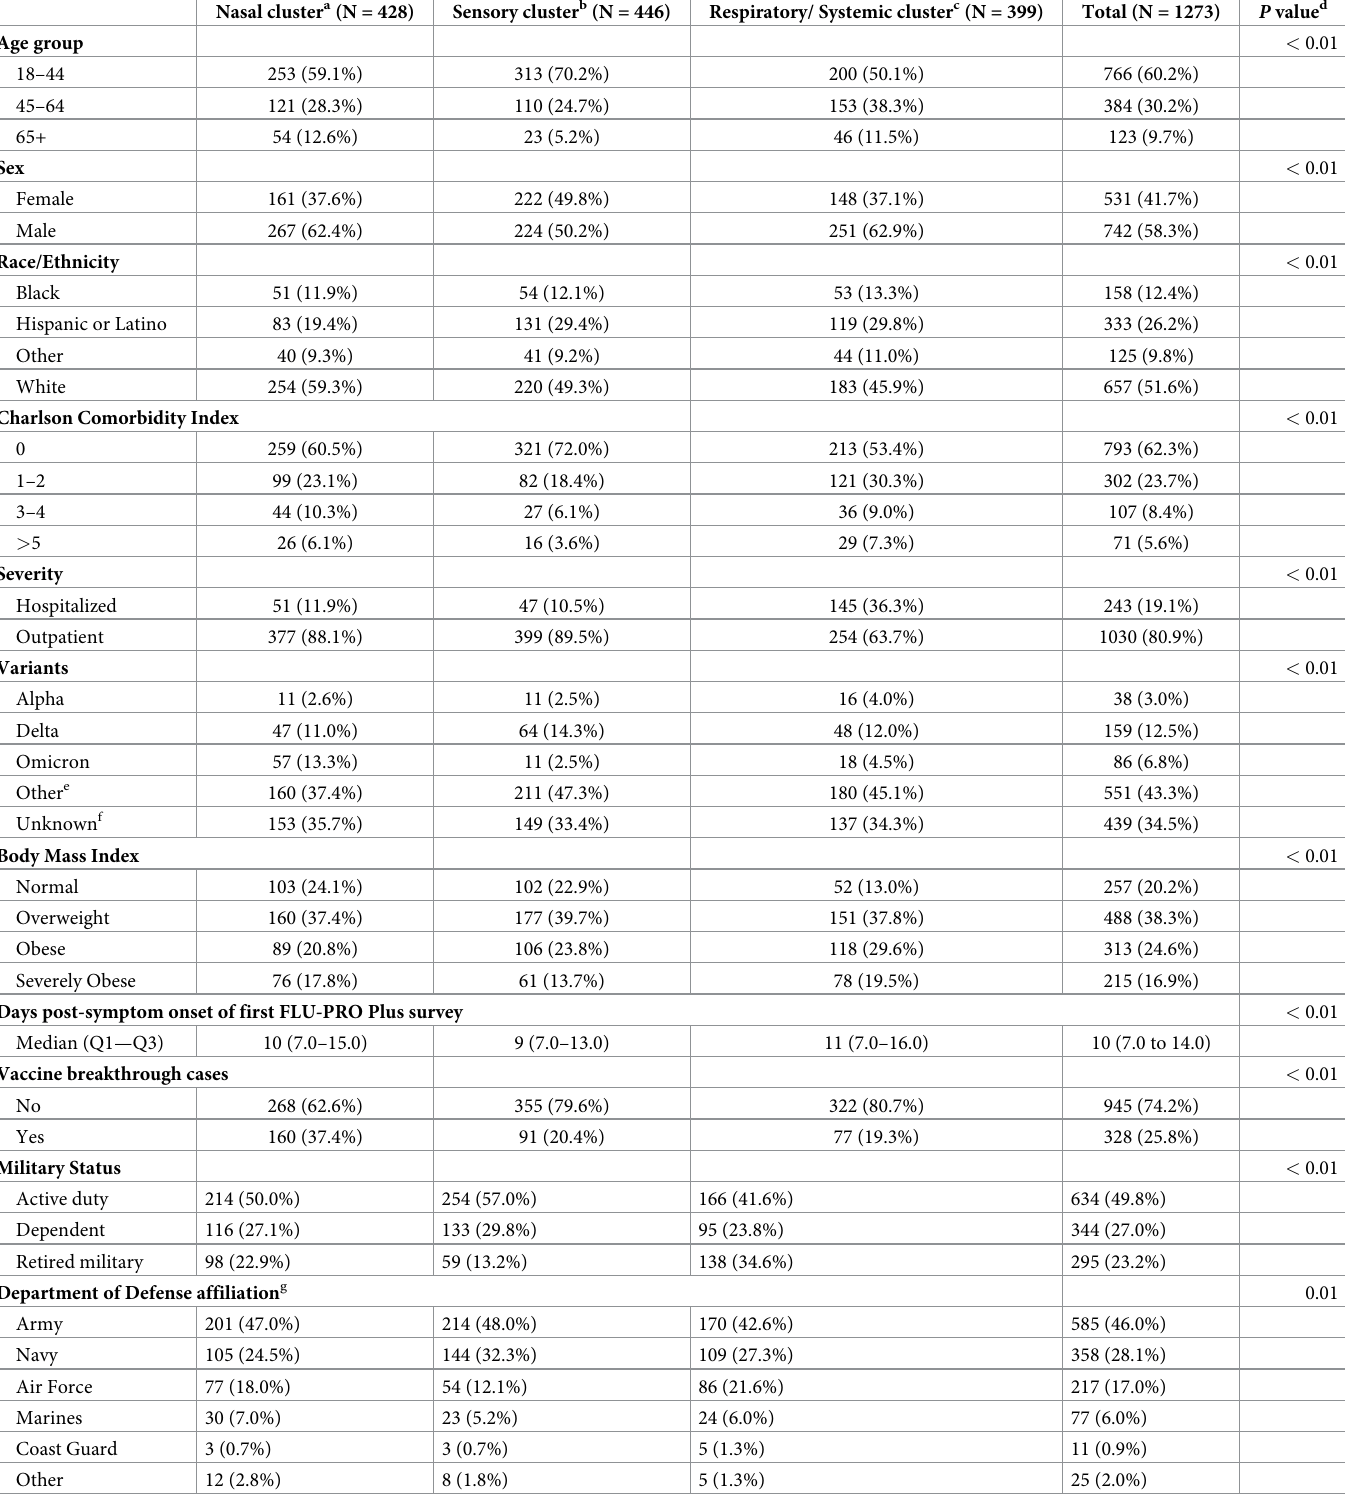
Table 1. Clinical and demographic characteristics of 1273 military health system beneficiaries by early FLU-PRO symptom